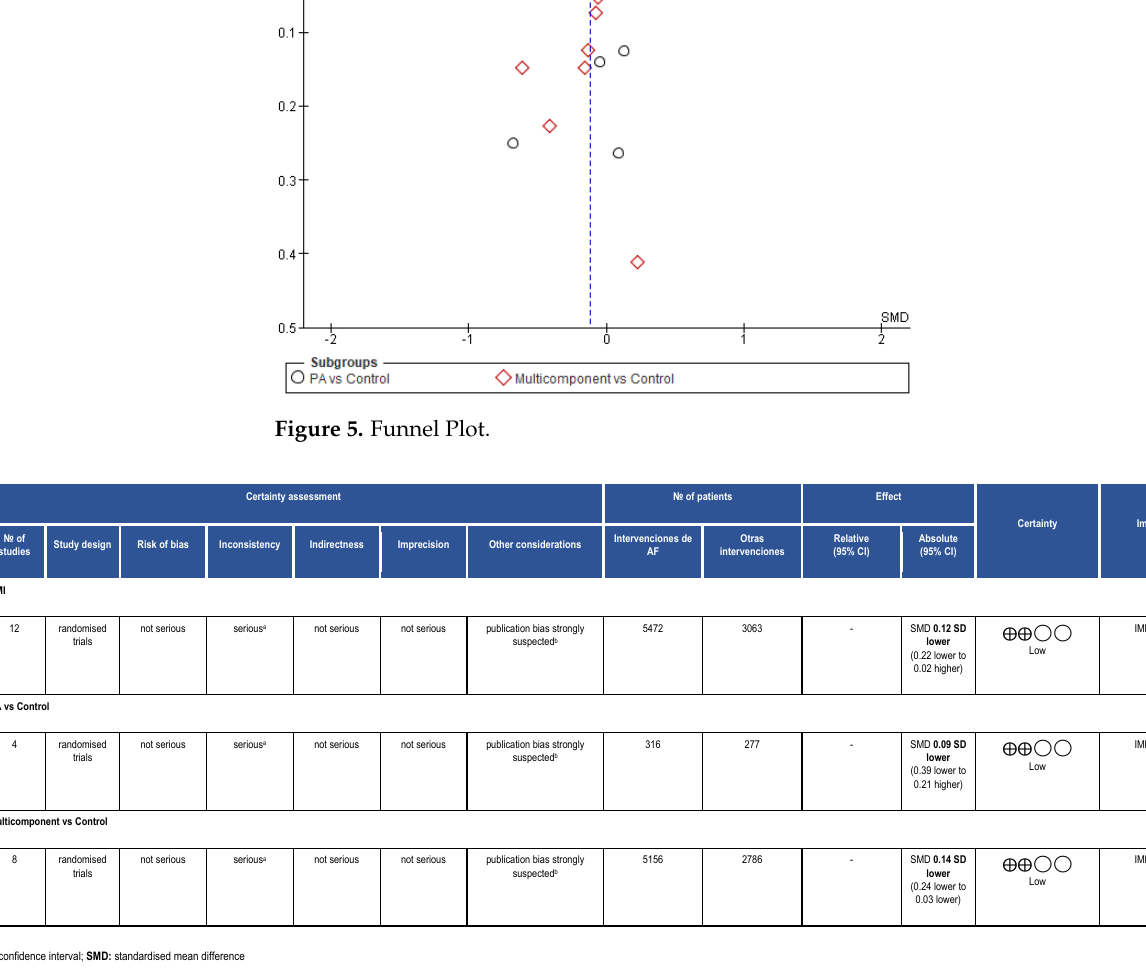
Figure 6. GRADE evaluation.